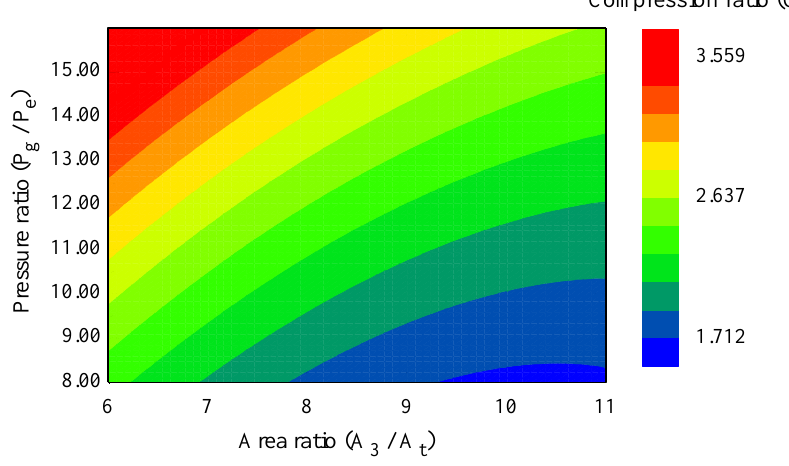
/ A t ) and pressure ratio ( P g